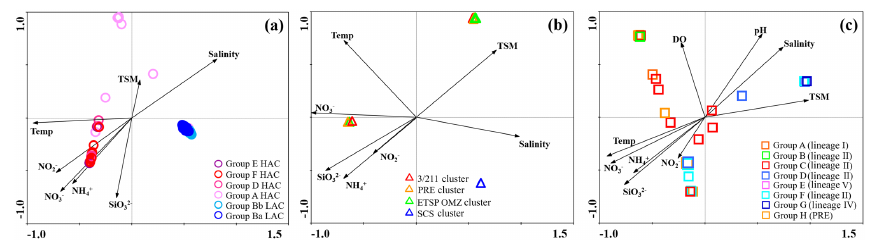
Figure 10. Canonical correspondence analysis (CCA). (a) Ammonia-oxidizing archaea, (b) Nitrospina , and (c) Nitrospira phylogenetic taxa under the constraint of environmental factors. Each symbol represents an individual OTU. Vectors represent the environmental variables. Temp stands for temperature. DO and pH were not included in (a) and (b) because they were not measured at